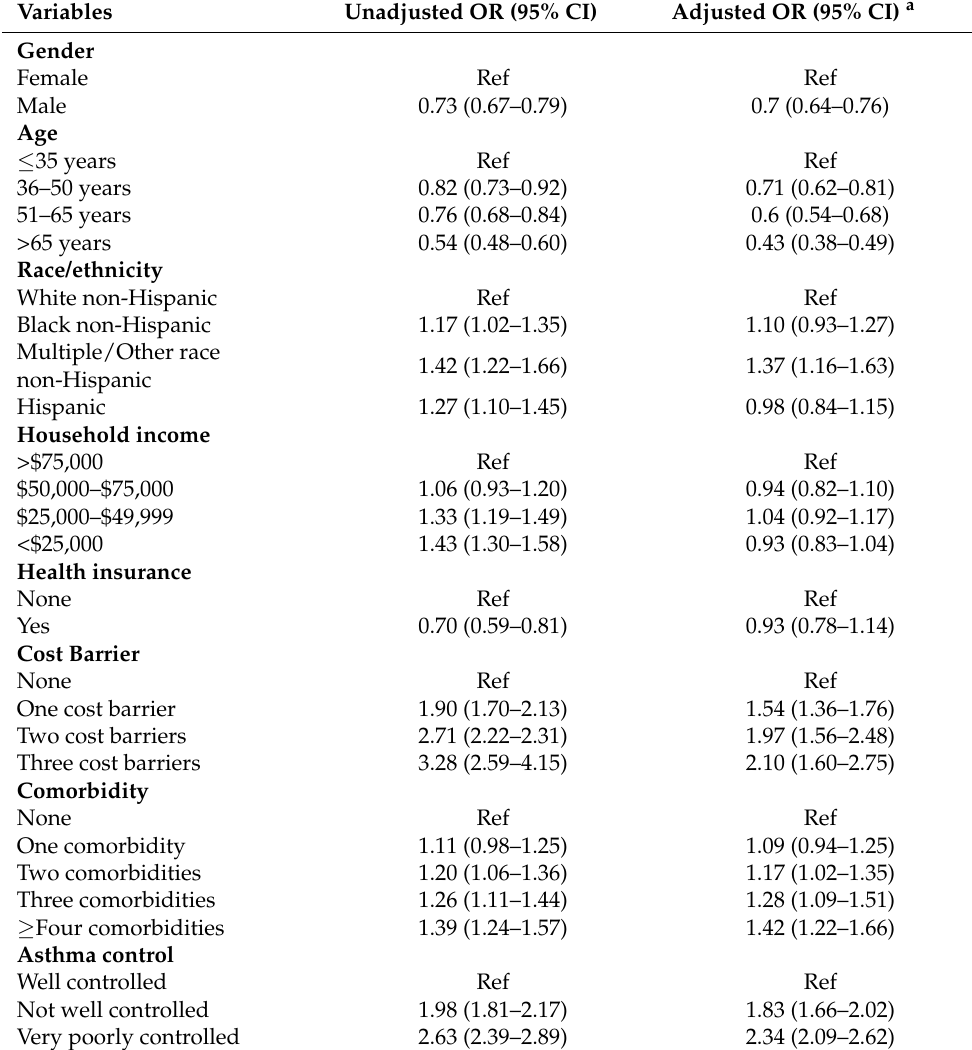
Table 3. Multivariable logistic regression of sociodemographic and health factors associated with CAM use among US adults with current asthma: Behavioral Risk Factor Surveillance System Asthma Call-back Survey,